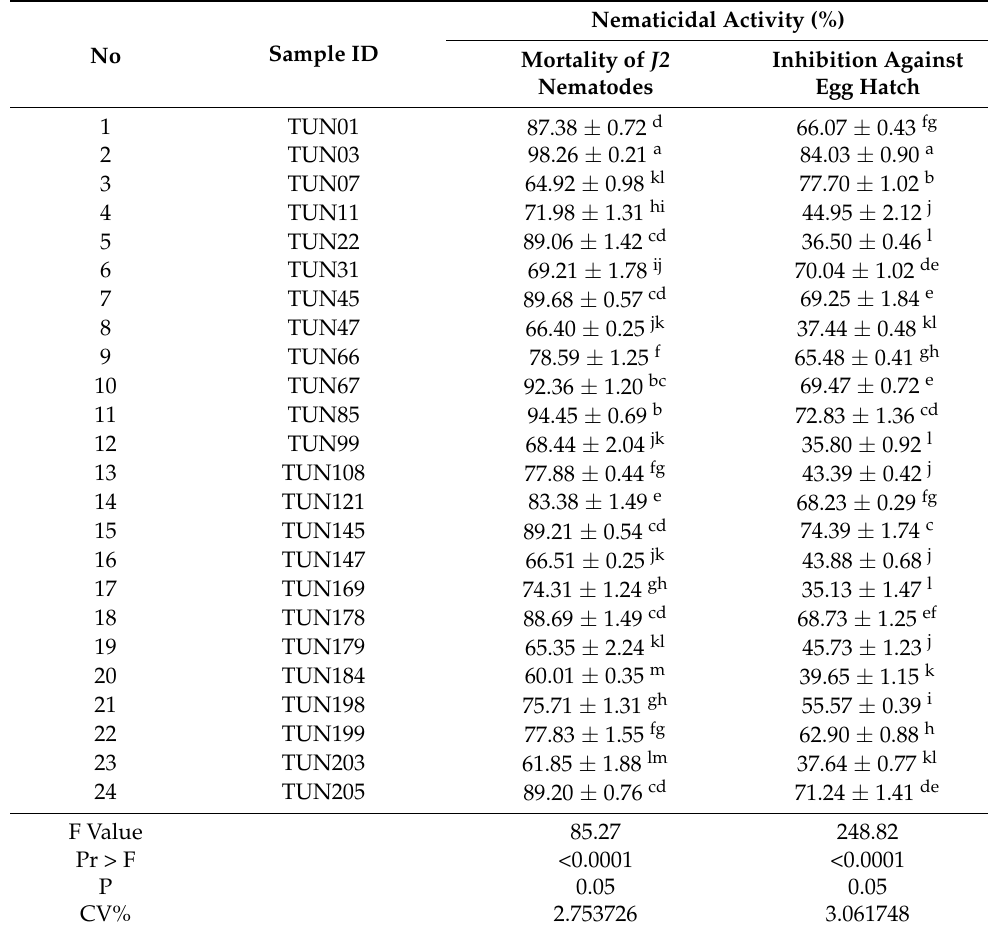
Table 1. Nematicidal activity of some anti-nematode rhizobacteria isolated in the Central Highland of Vietnam.